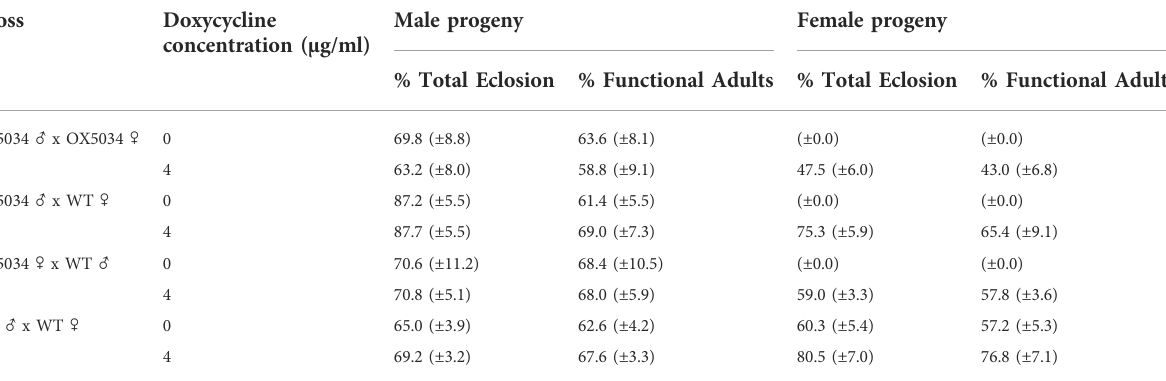
TABLE 1 OX5034 Aedes aegypti homozygote, hemizygote and WT penetrance on and off doxycycline. Percentages are means of L 1 individuals reaching the speci fi ed stage based on initial counts of 200 L 1 larvae per repeat (5 repeats) and assuming a 1:1 sex ratio. 95% con fi dence intervals are displayed in parentheses. Note that in the case of female OX5034 progeny, zero female adults (functional or otherwise) were identi fi ed in any of the crosses without doxycycline.